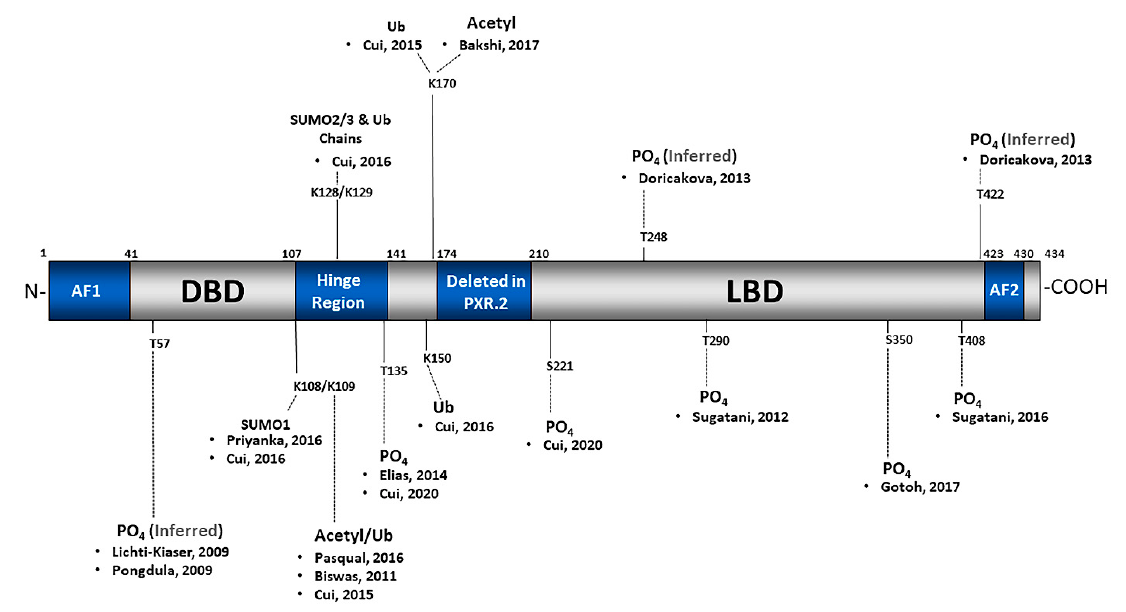
Figure 4. This scheme provides the specific sites and types of PXR PTMs and their associated references.